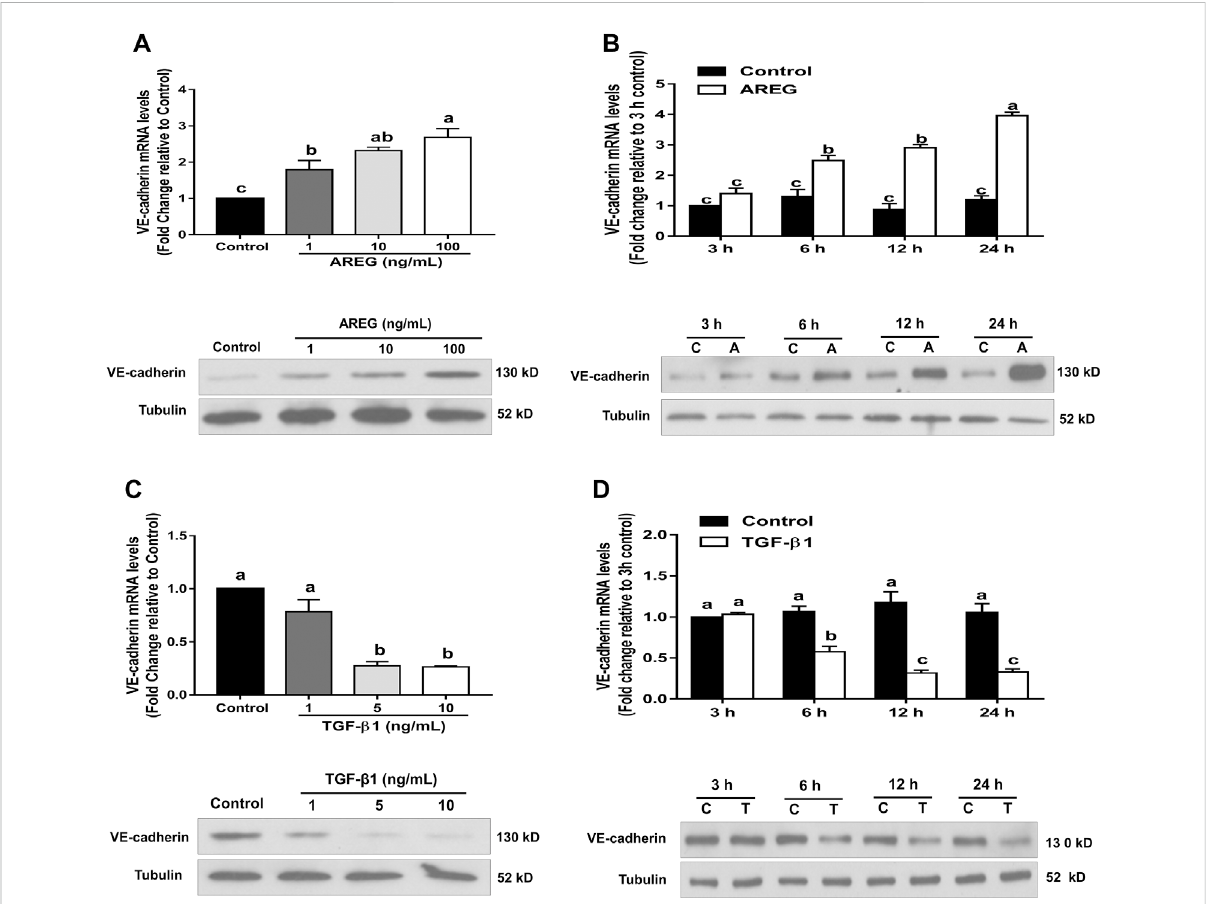
FIGURE 3 Effects of AREG and TGF- β 1 on VE-cadherin expression in SOVG cells. (A,C) SVOG cells were treated for 24 h with or without varying concentrationsofAREG(1,10or100 ng/ml) (A) orTGF- β 1(1, fi veor10 ng/ml) (C) ,andtheexpressionlevelsofVE-cadherinwereexaminedusingRT- qPCR and western blotting, respectively. (B,D) SVOG cells were treated with or without AREG (100 ng/ml) (B) or TGF- β 1 (10 ng/ml) (D) for 3, 6, 12 or 24 h,andtheexpressionlevelsofVE-cadherinwereassayedbyRT-qPCRandwesternblotting,respectively.Valueslabeledwithdifferentletters are signi fi cantly different ( p < 0.05), n = 3. C, control; A, AREG; T, TGF- β